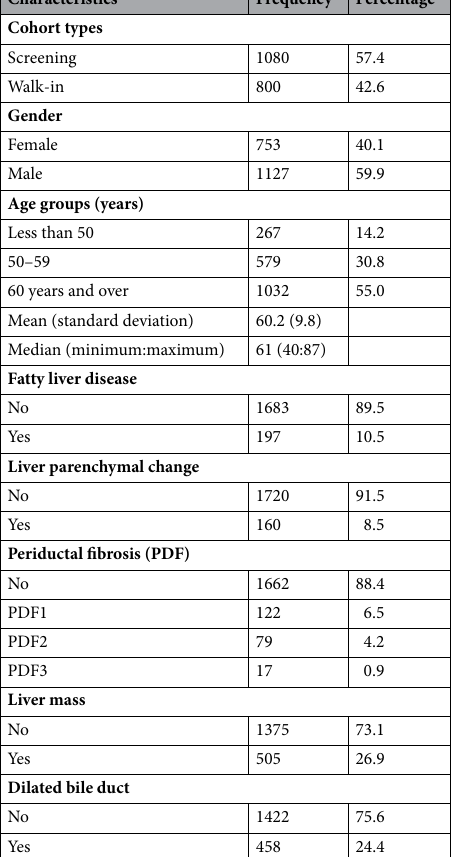
Table 1. Base line characteristics and ultrasound findings of participants in the CASCAP study 2013–2020.